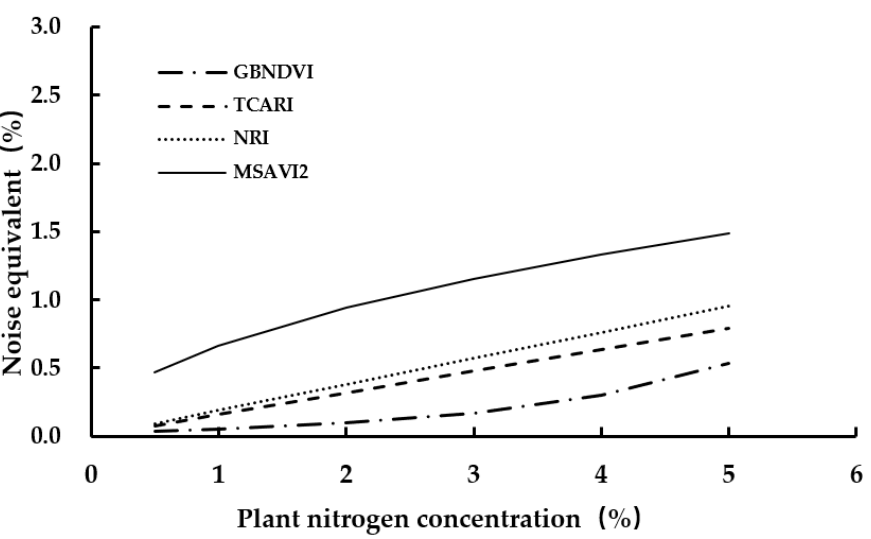
Figure 6. Noise equivalent of plant nitrogen concentration estimation by the spectral indices of GBNDVI, TCARI, NRI, and MSAVI2.